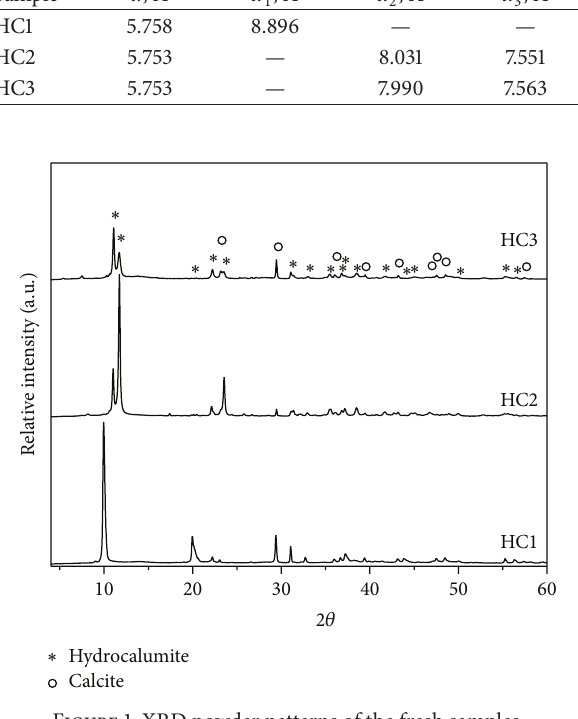
Figure 2: XRD powder patterns of the calcined samples at 700 ∘